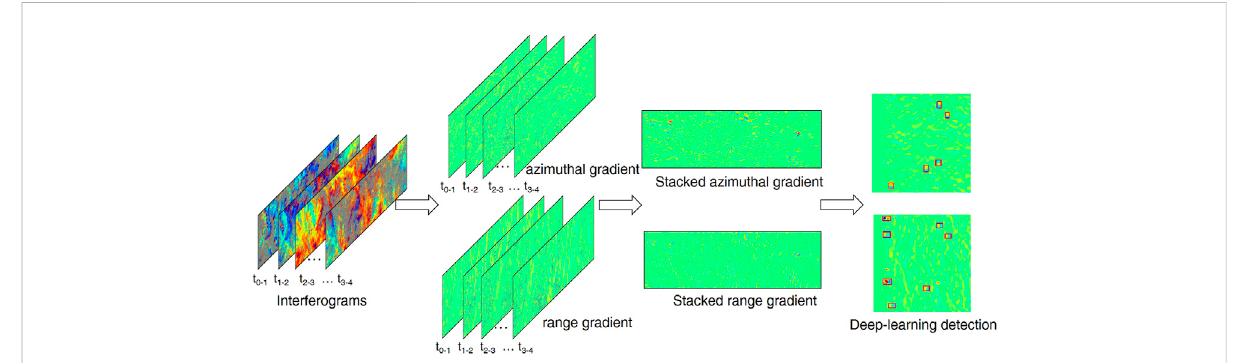
FIGURE 3 The work fl ow of the proposed method for one burst image. The phase-gradient stacking and detection are both performed in the radar coordinate for each burst of